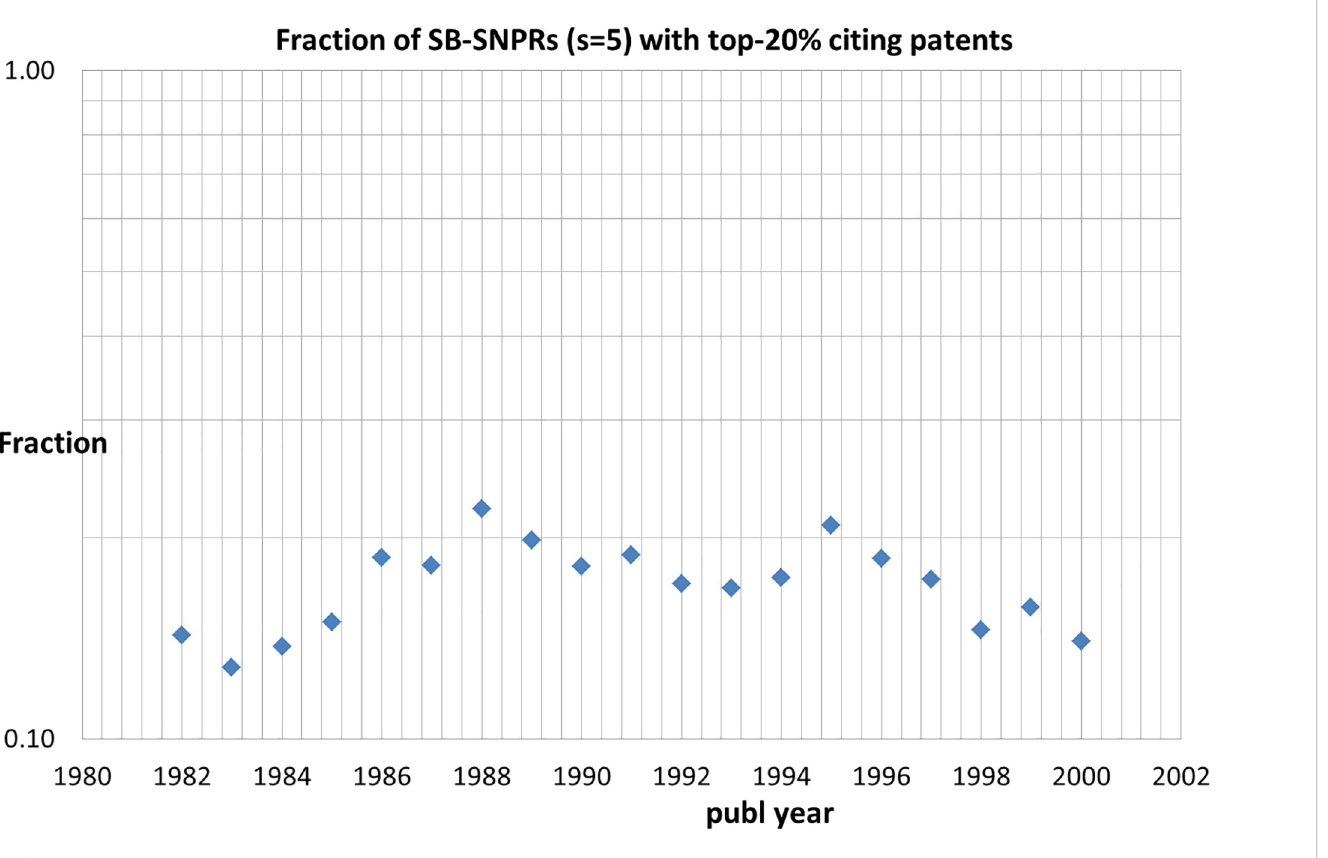
Fig 21. Fraction of SB-SNPRs ( s = 5) that are cited by top-20% patents.